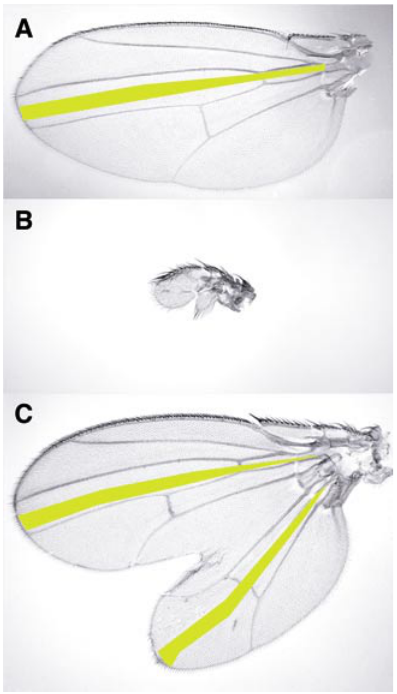
Figure 2. Changing the Patterning Mechansims during Wing Development Affects Growth Compared with a wild-type wing (A), loss of Dpp function results in reduced growth and loss of pattern elements (B). Ectopic expression of Dpp in a clone of cells results in pattern duplications associated with massive extra growth (C). The region of Dpp expression in (A) and (C) is indicated by the green color. (Zecca et al. 1995; pictures courtesy of B. Müller and K. Basler.)